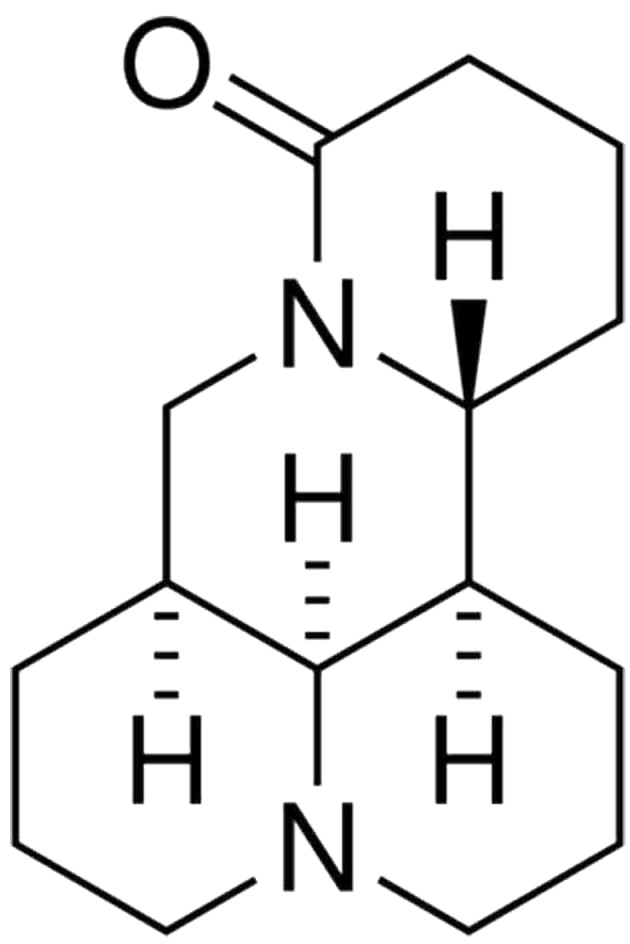
Chemical structure of matrine (C15H24N2O).